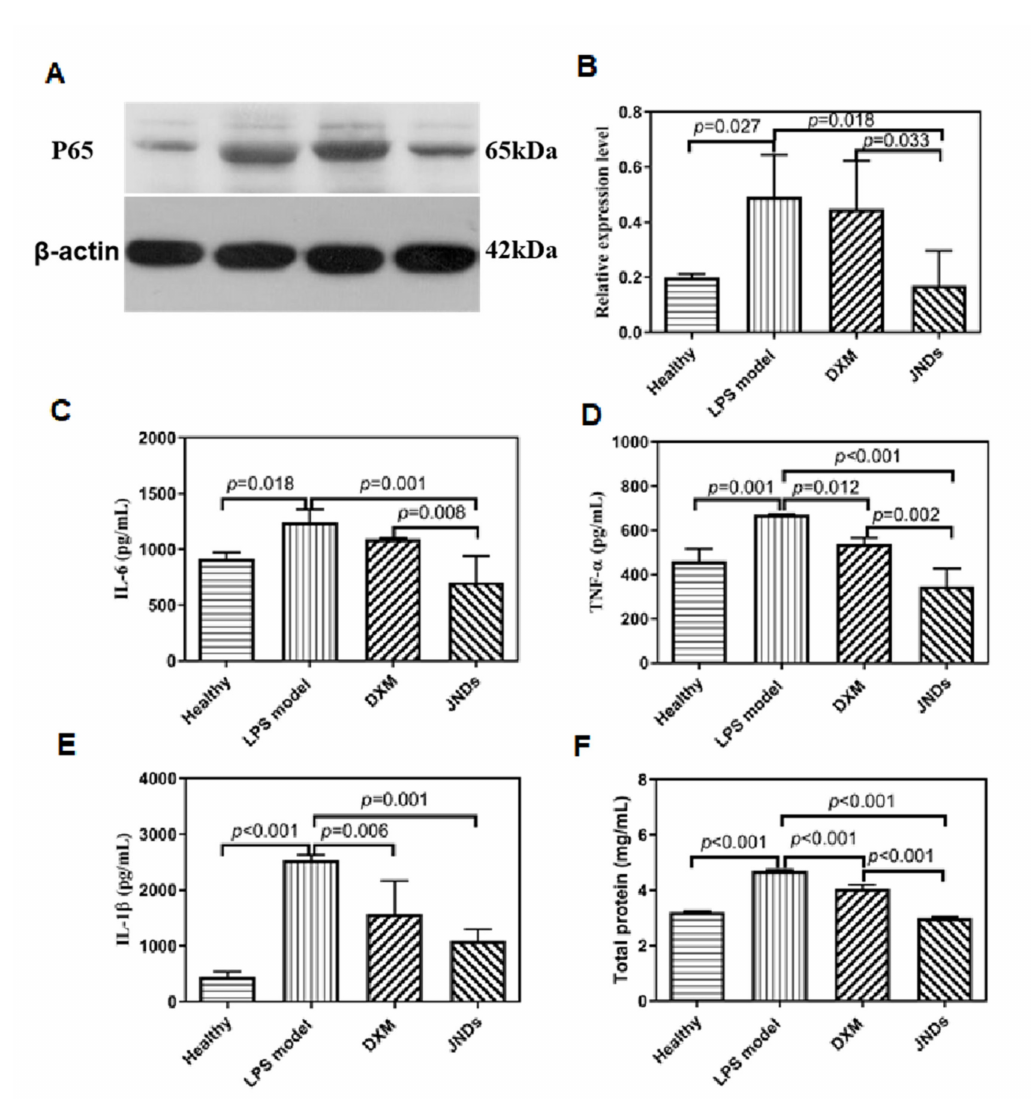
Figure 3. ( A ) Western blotting images of NF- κ B p65 proteins. Left to right: the healthy rats, the LPS-induced ALI rats, the DXM group, and the JNDs group. ( B ) Relative expression levels of NF- κ B p65 proteins compared to the actin standards in different groups according to Graph ( A ); ( C ) expressions of IL-6 according to Graph ( A ); ( D ) expressions of TNF- α according to Graph ( A ); ( E ) expressions of IL-1 β according to Graph ( A ); ( F ) total proteins in the lung tissues from the different groups. The data are presented as means ± SD ( n =